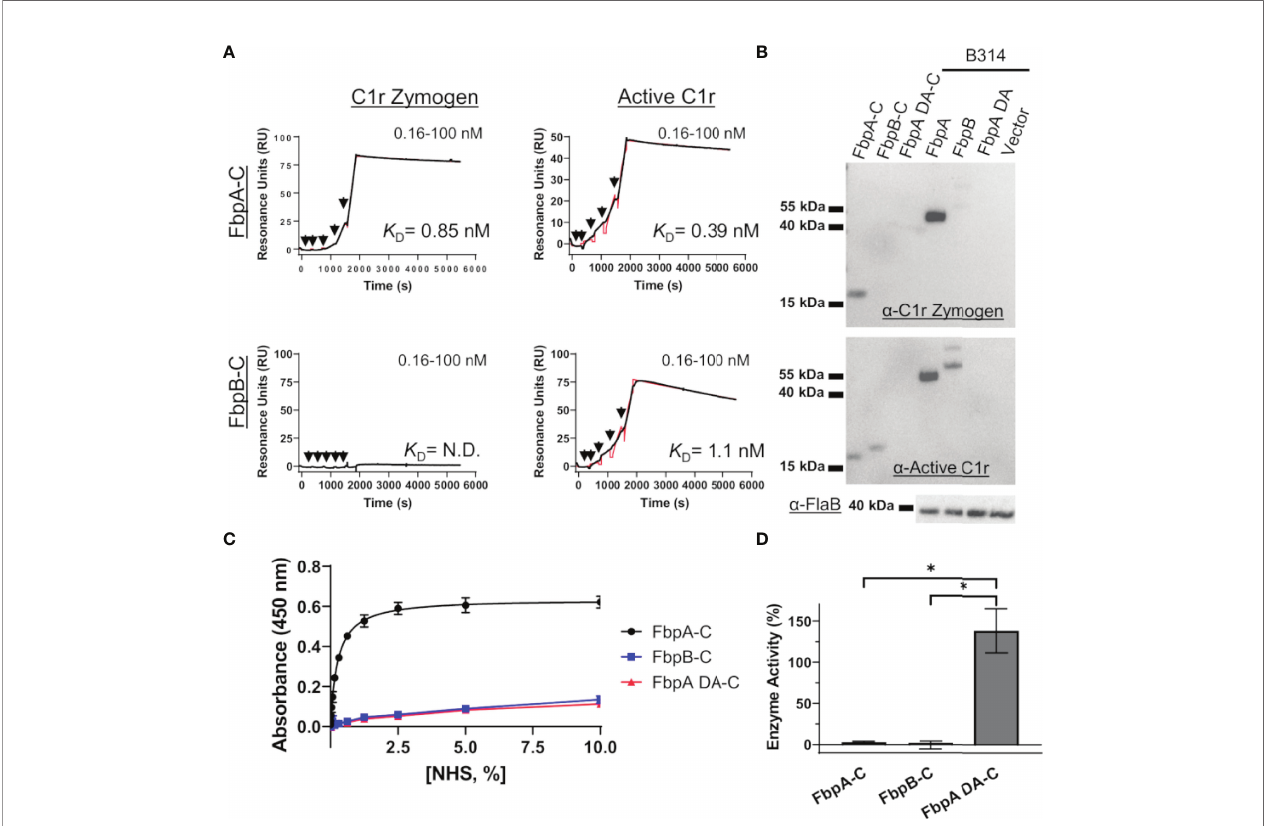
FIGURE 6 | FbpA-C and FbpB-C interact differentially with zymogen and activated forms of human C1r. (A) Single cycle SPR was used to determine binding af fi nities of C1r zymogen or active C1r ranging from 0.16 - 100 nM injected over immobilized Fbps. A representative sensorgram from a three-injection series for each Fbp-C and C1r active state is shown with the black curve being the sensorgram and the red curve the associated kinetic fi t. K D ’ s were determined using kinetic fi ts and are shown as the average and standard deviation of three replicates in Table 4 . (B) Far Western overlays using B. burgdorferi B314 lysates probed with zymogen or enzymatic forms of puri fi ed full-length C1r, followed by an antibody to C1r. (C) An ELISA-type binding assay was used to determine the ability of FbpA-C, FbpA DA-C and FbpB-C to interact with C1r in human serum. FbpA-C (black), FbpB-C (blue), and FbpA DA-C (red) were immobilized on an ELISA plate then incubated with a two-fold dilution series of normal human serum ranging from 0.0012-10%. Corresponding EC 50 values for FbpA-C, FbpB-C, and FbpA DA-C are reported in Table 4 . (D) Fbp-mediated inhibition of puri fi ed active C1r-CCP2-SP enzymatic activity was assessed by incubating 15 nM C1r-CCP2-SP with a 1 m M of FbpA-C (white), FbpB- C (striped), and FbpA DA-C (grey). C1r-CCP2-SP enzymatic activity was determined by incubation with a C1r substrate (Z-Gly-Arg-sBzl) that, once cleaved, reacts with DTNB resulting in a colorimetric change. No statistical difference was found between FbpA-C and FbpB-C inhibitory activity, whereas FbpA DA-C exhibited signi fi cant loss in inhibitory activity. Statistical analysis was performed using a one-way ANOVA followed by a multiple comparison Tukey test